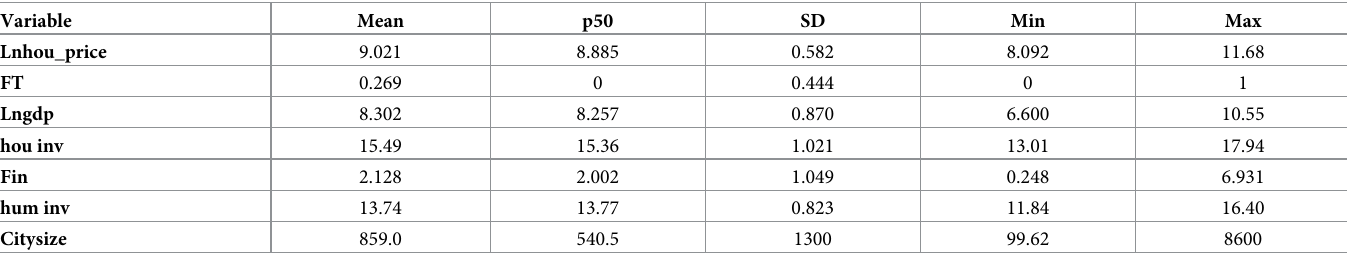
Table 2. Descriptive